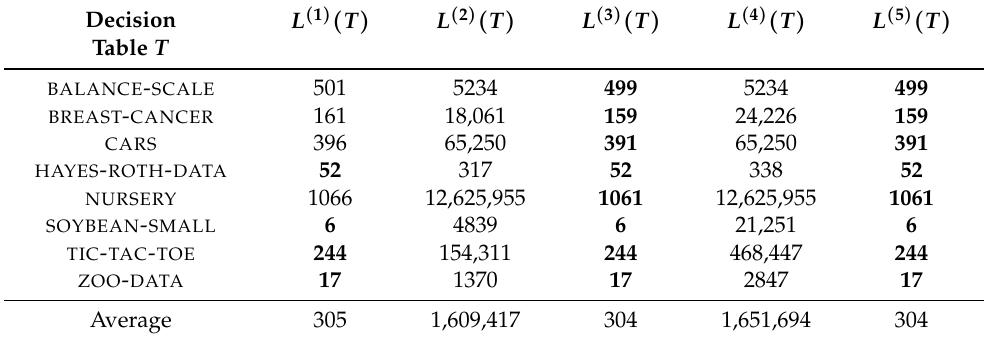
Table 4. Experimental results for decision tables from Reference [20]—number of realizable nodes.